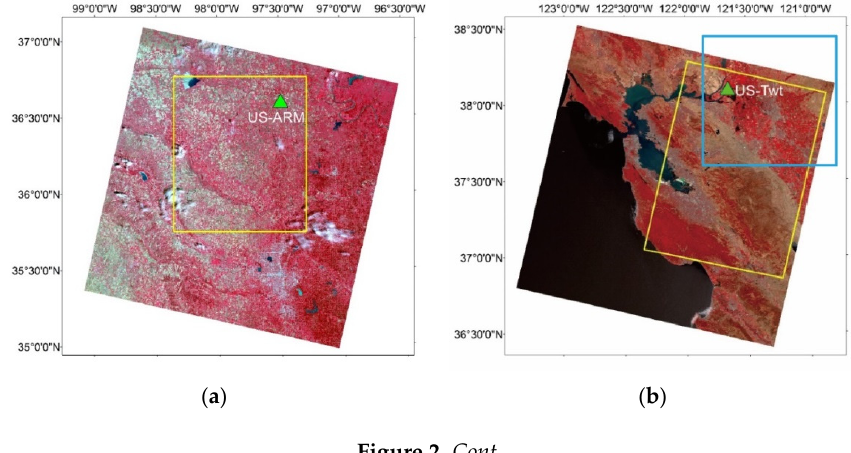
Figure 2. Cont. Figure 2.